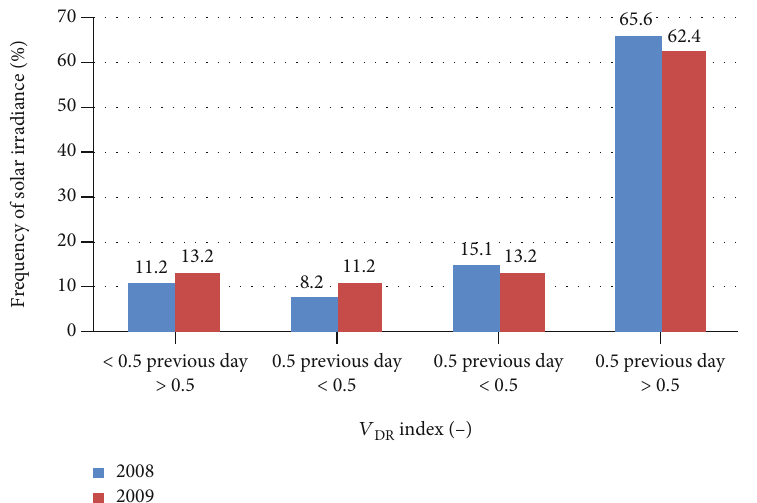
Figure 9: Relative frequency of solar irradiance/clouding situations quanti fi ed by the V station.